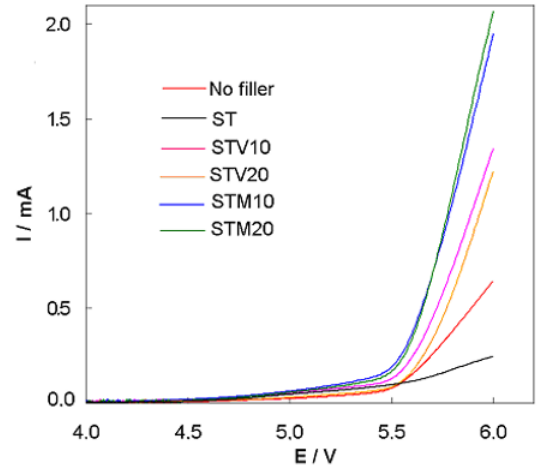
Figure 6. Linear sweep voltammetry curves recorded on platinum electrode for the gel electrolytes with the examined